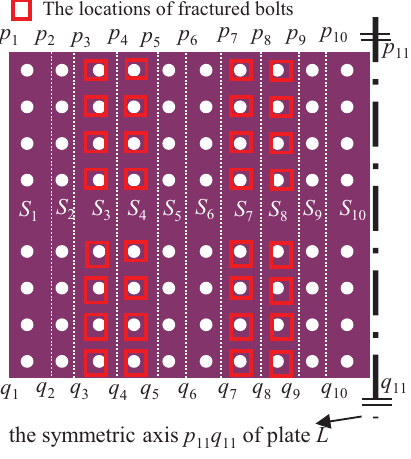
the symmetric axis p